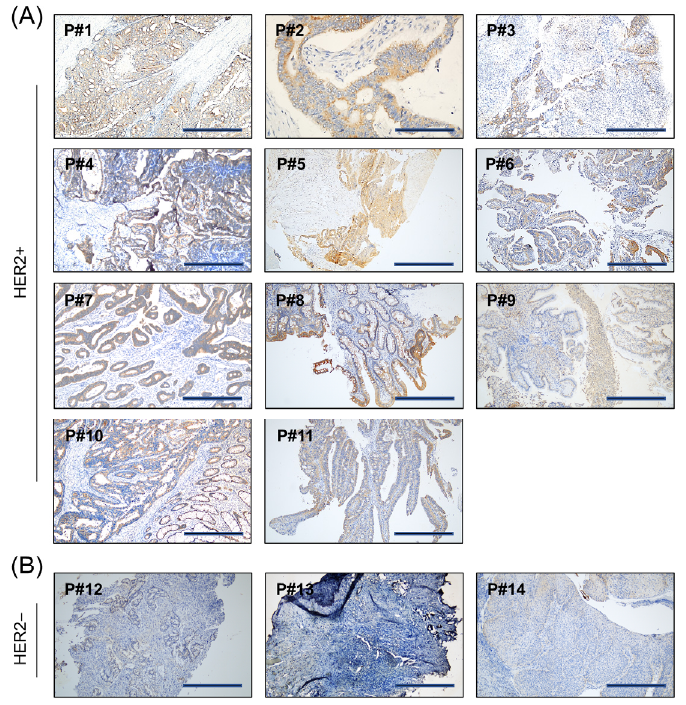
Figure 3. HER2 protein expression was detected by IHC staining in the 14 (P#1 to P#14) included patient samples. Images are representative IHC staining images of the 11 HER2+ ( A ) and 3 HER2 − ( B ) patient samples. Scale bar, 100 μ m.